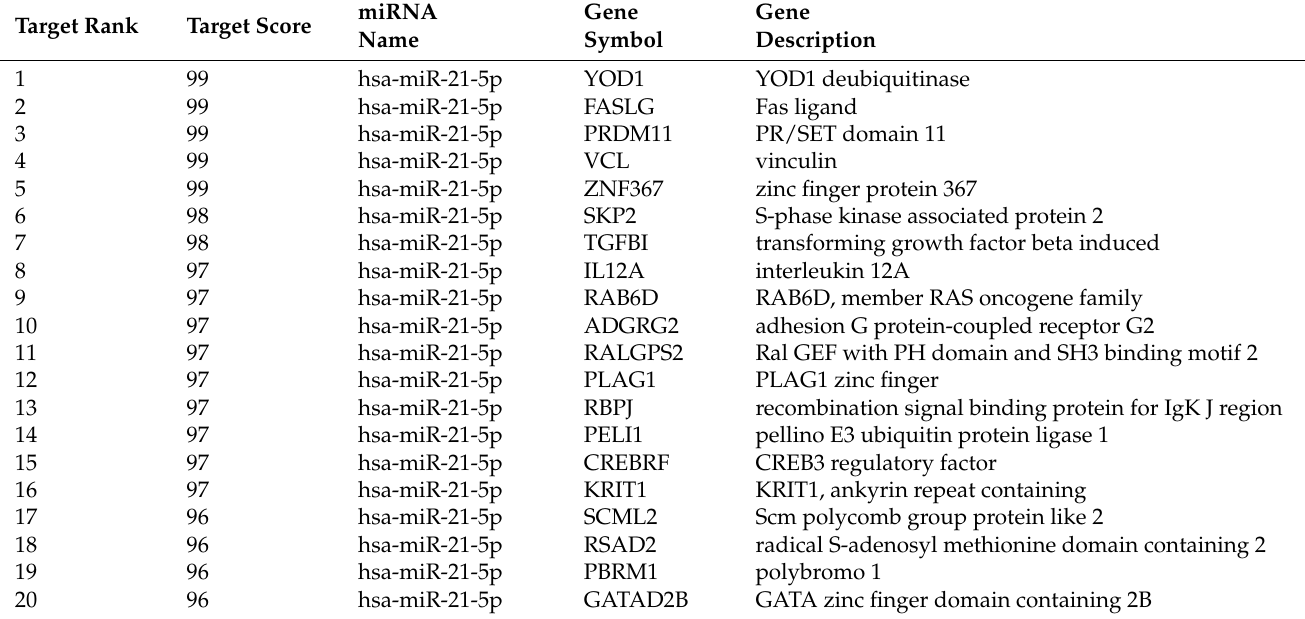
Table 2. Top 20 gene targets of hsa-miR-21-5p. Identification of the predicted targets of hsa-miR-21-5p with a prediction score >94 using